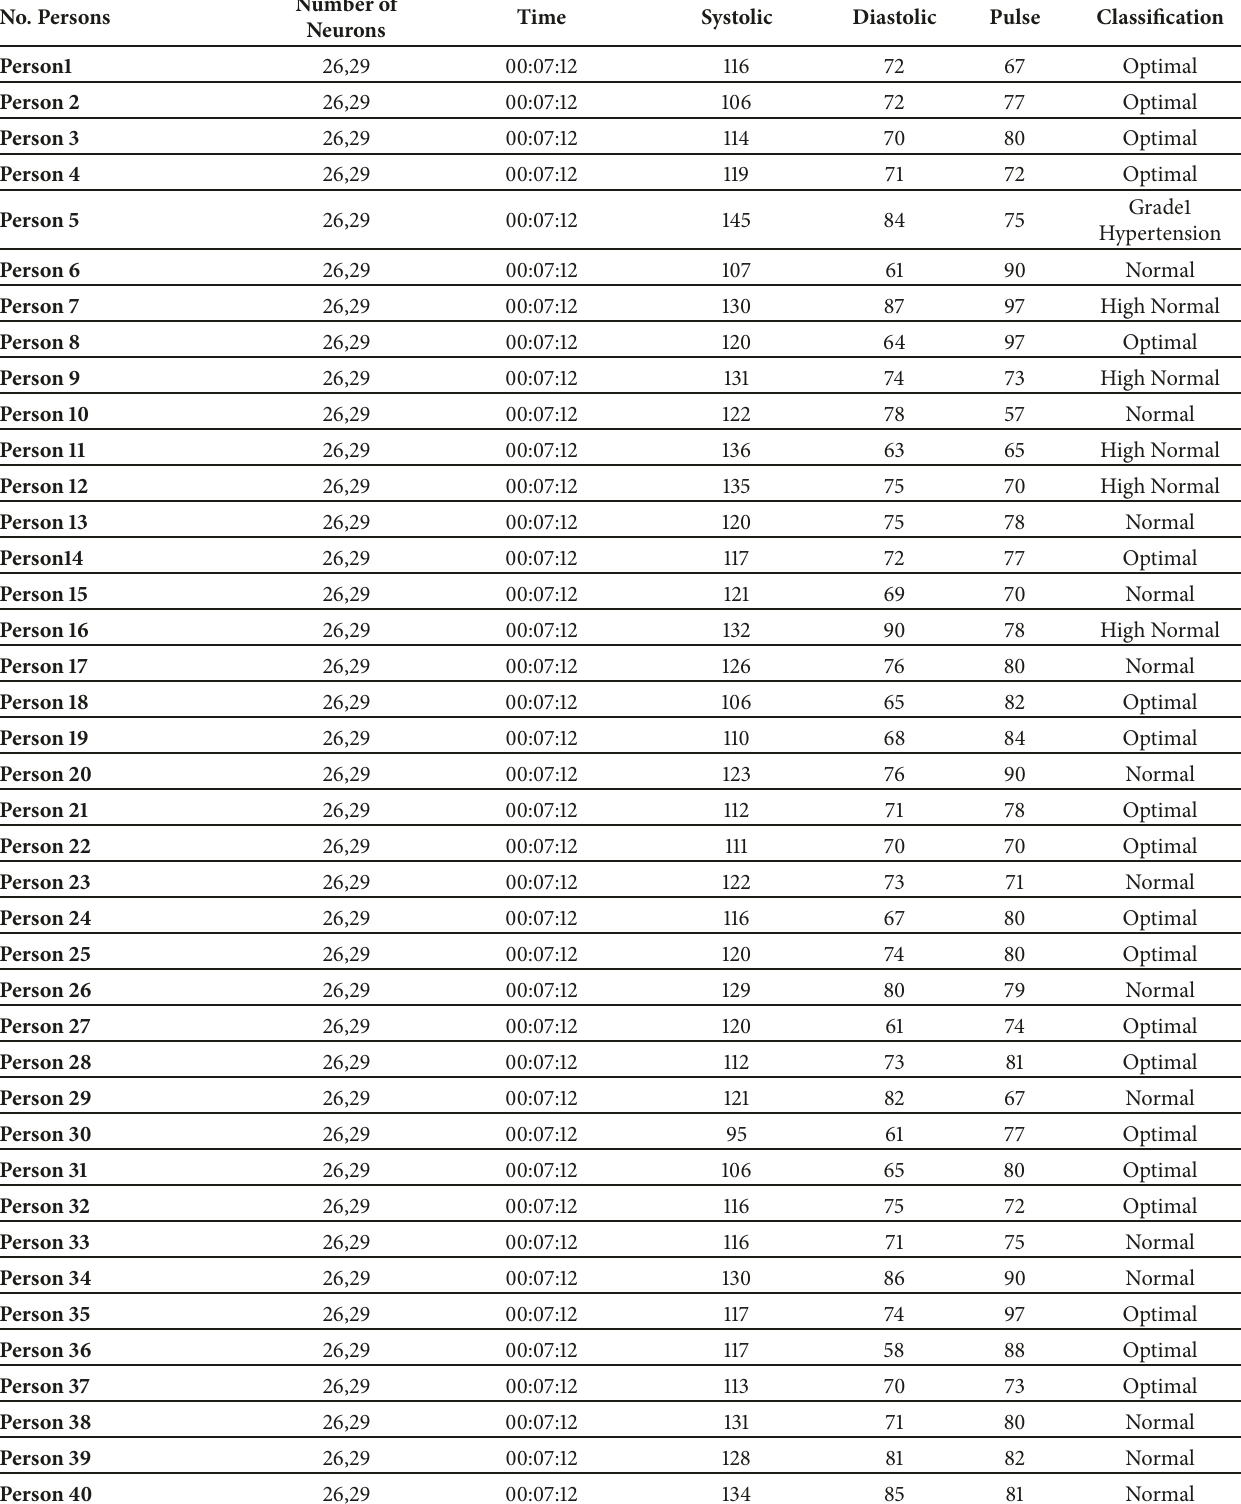
Table 5: Classification for MNN with train method